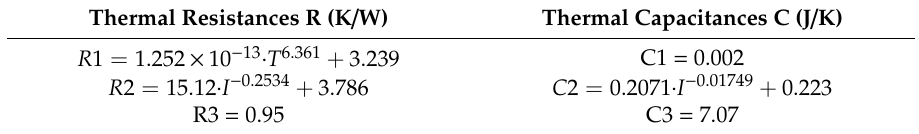
Table 2. Element values of the parametrized Cauer CTM for LED with the thermal not connected. Thermal Resistances R (K / W)